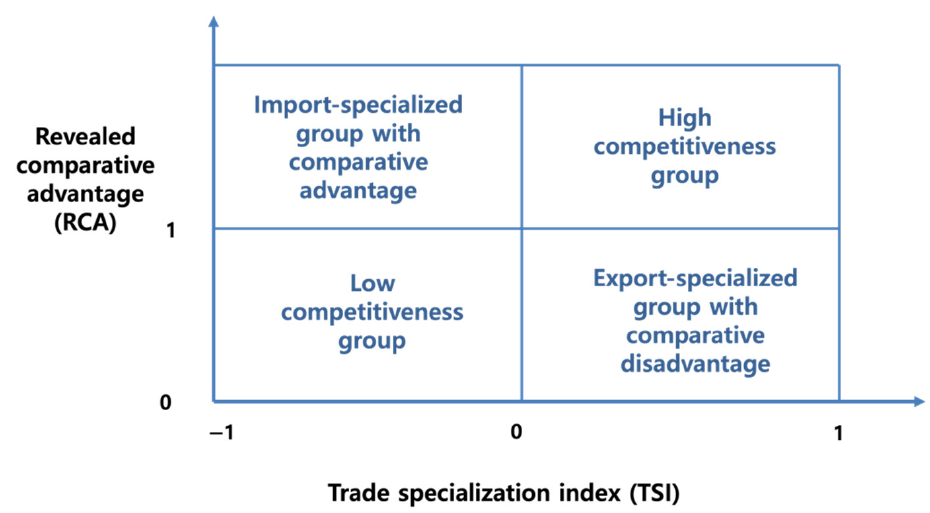
Figure 5. Portfolio classification of trade specialization index and revealed comparative advantage index.